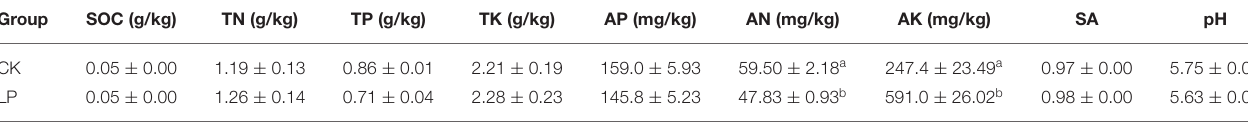
TABLE 1 | Soil properties of LP soils and CK soils. Group